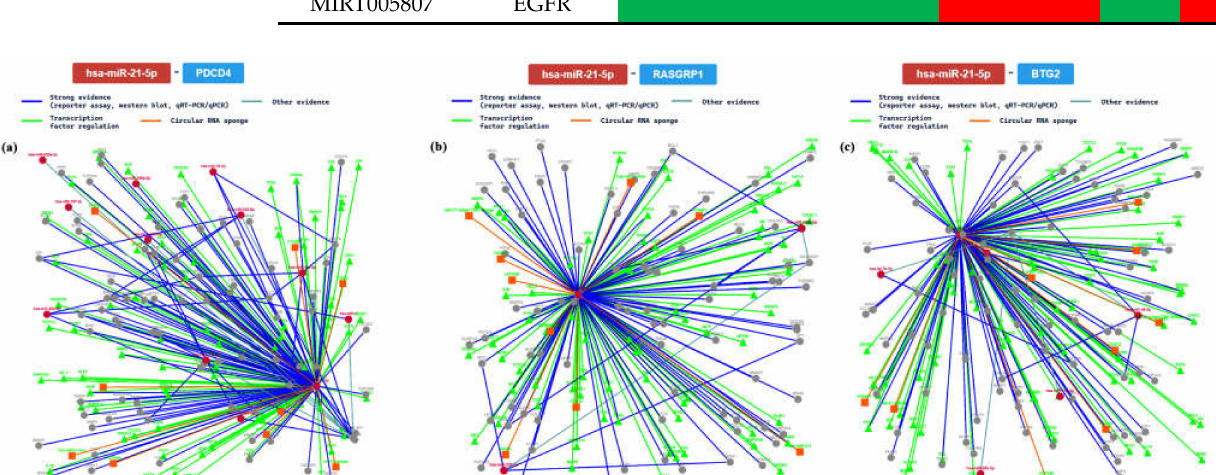
Figure 6. The regulatory network of has-miR-21 and the PDCD gene ( a ); ( b ) shows the regulatory network of interaction between the tested miRNA and the RASGRP1 gene; ( c ) shows the network relative to the BTG2